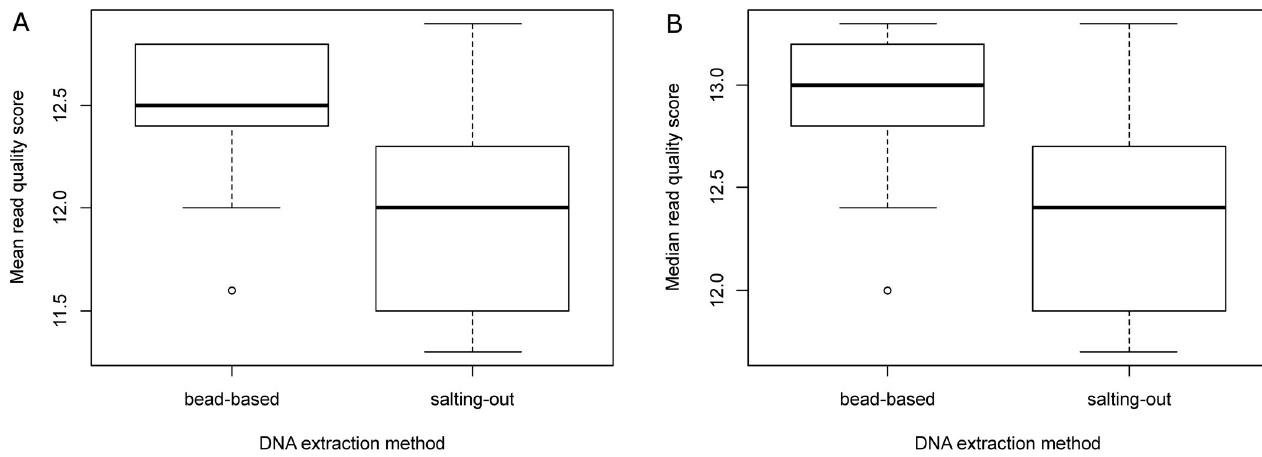
Fig 4. Quality metrics of the sequencing data according to the DNA extraction method. (A) Mean read Q score, (B) Median read Q score.